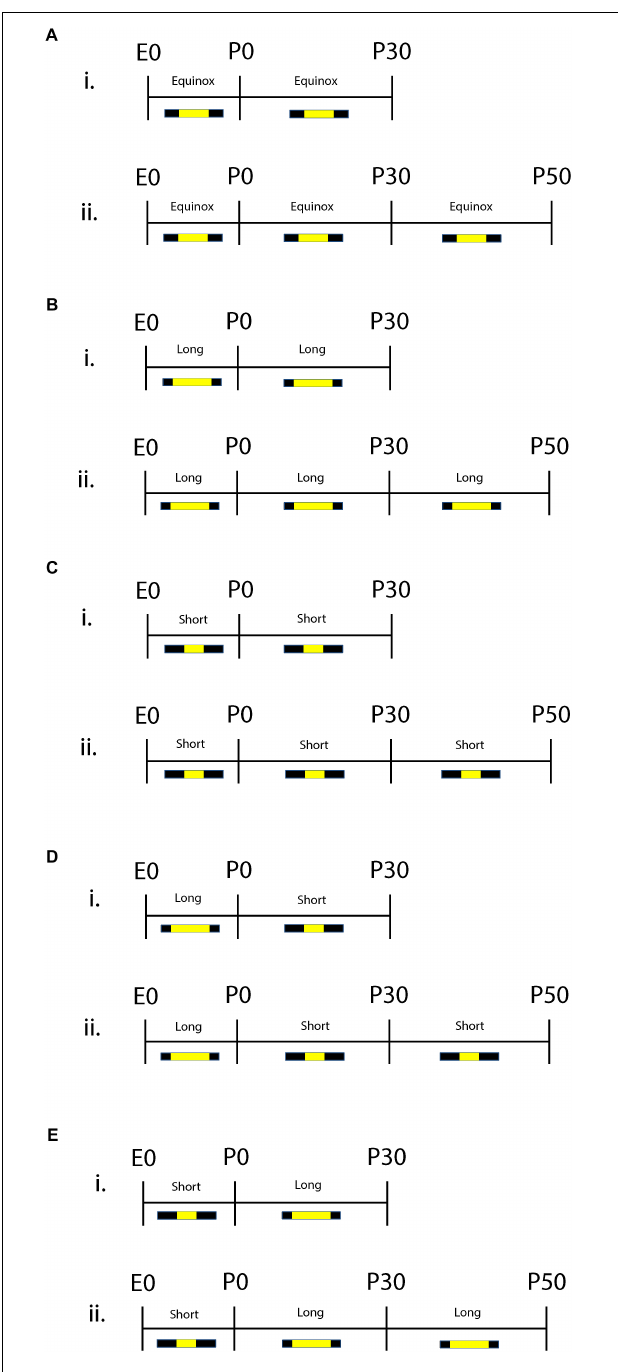
FIGURE 1 | Schematic of developmental photoperiod paradigm. Animals were maintained on Equinox (Eq) (A) , Long (L) ( B), or Short (S) (C) photoperiods from E0 to P30 or P50. One cohort of animals developed from E0 under Long photoperiods and were switched to Short photoperiods (L-S) at birth (P0) ( D). Another cohort of animals were developed from E0 under Short photoperiods and were switched to a Long photoperiod at birth (S-L) ( E). Experiments were performed at two different time points: P30 (i) or P50 (ii) . Photoperiods were defined as follows: Equinox, LD 12:12; Long, LD 16:8; Short, LD 8:16 where L, light; D, dark (i.e., LD 8:16 means Light for 8 h, Dark for 16